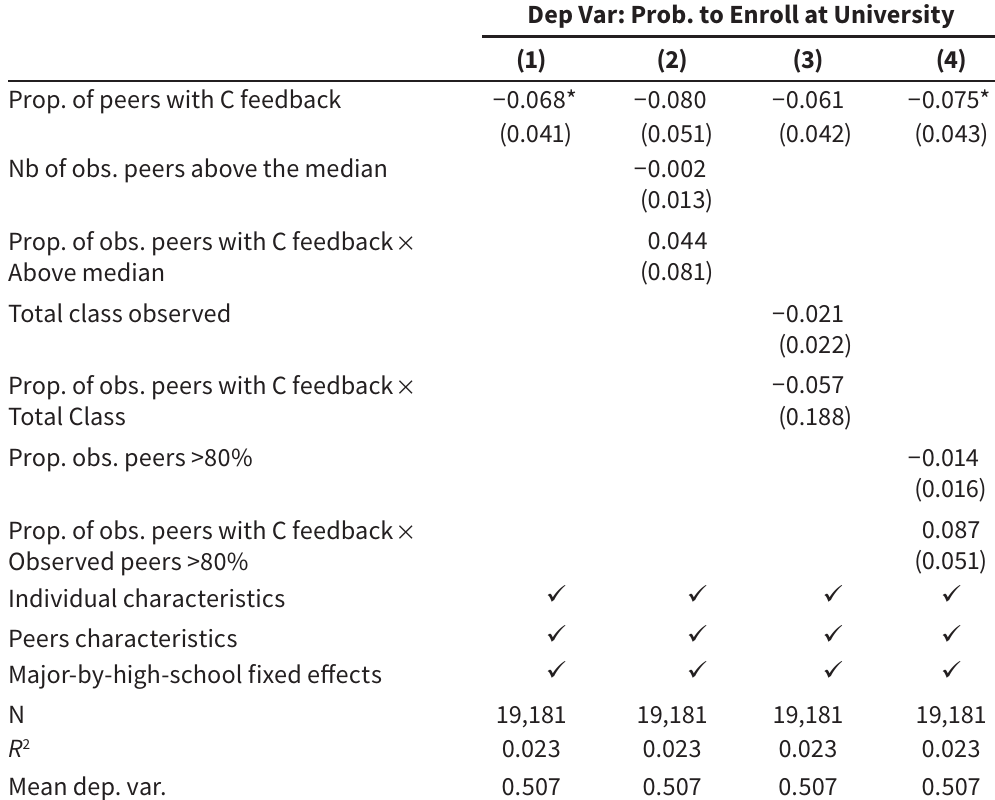
Table 7 Heterogeneous effects: Regressions by number of observed peers Dep Var: Prob. to Enroll at